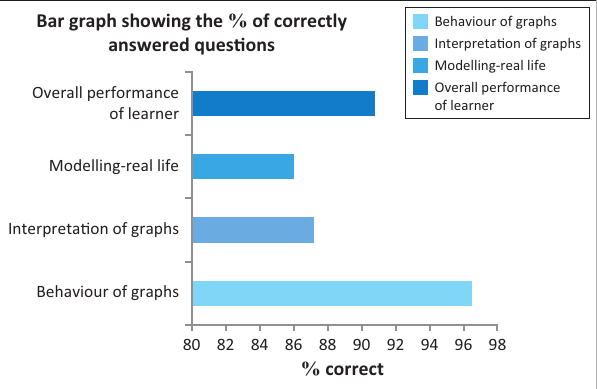
FIGURE 3: Graphical representation of the percentage of correctly answered questions in the second worksheet. TABLE 1: Learner competence when working within a dynamic online environment.